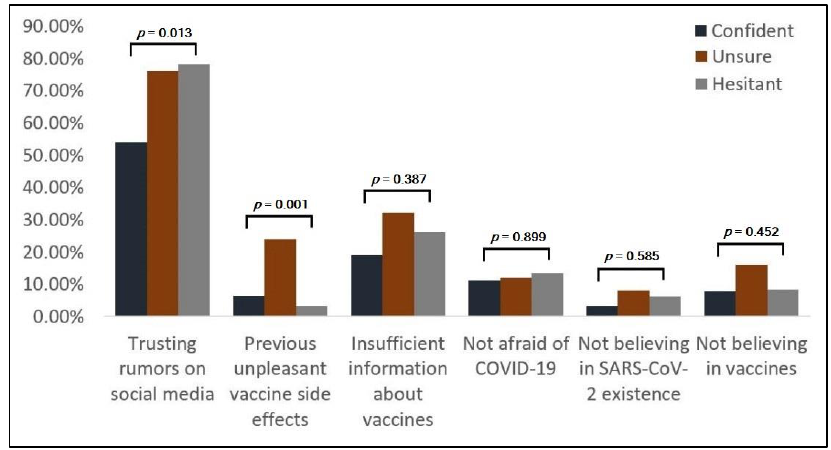
Figure 1. Differences among pregnant study participants based on decision factors.